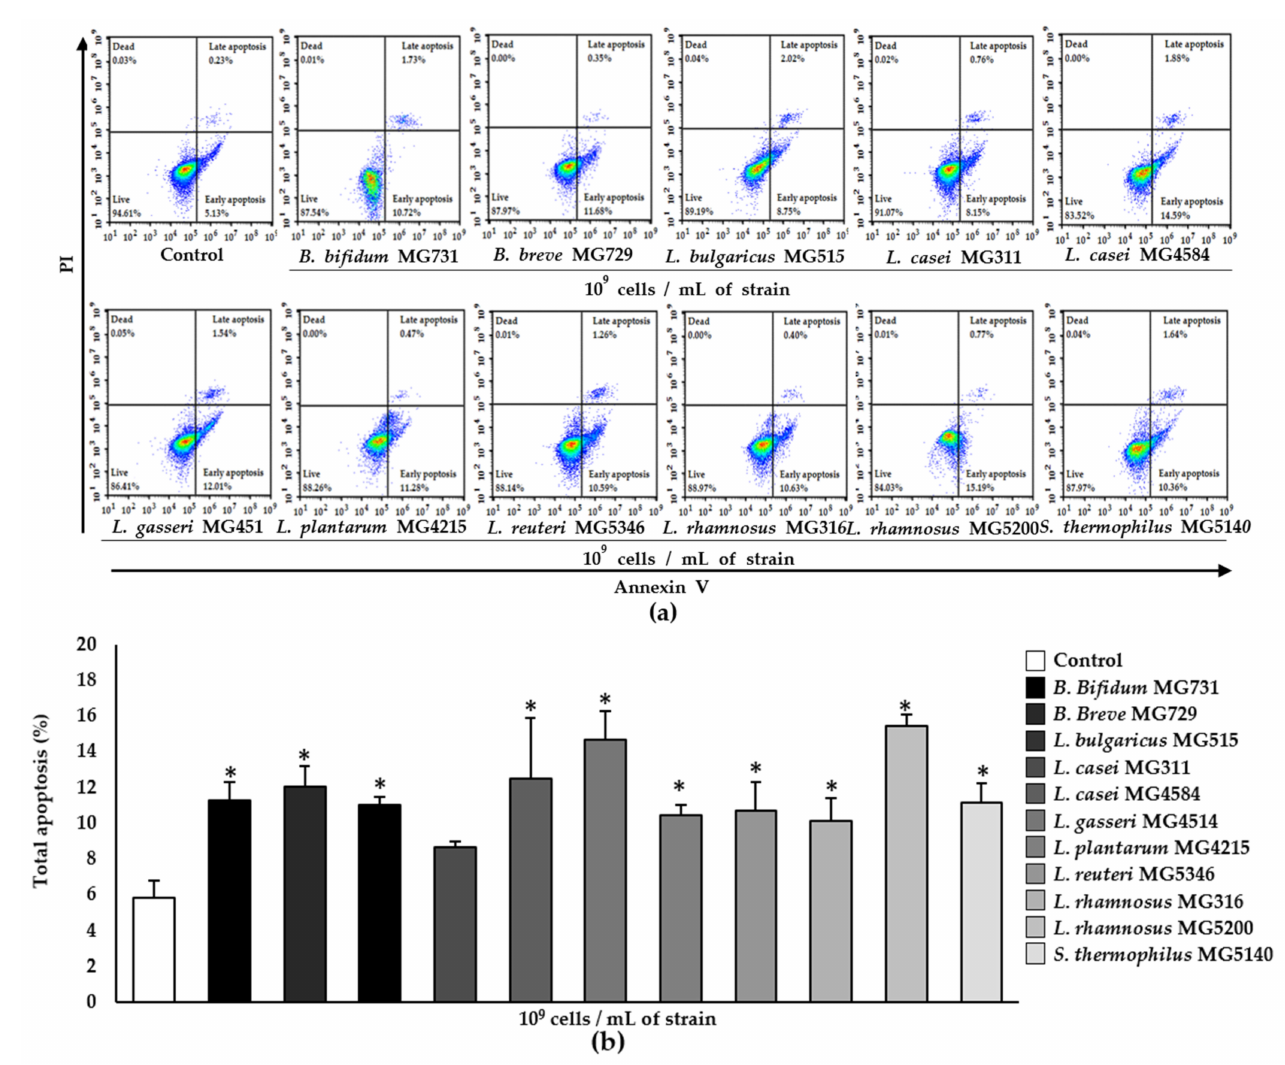
Figure 2. Apoptosis induced by heat-killed Bifidobacterium and Lactobacillus in RKO cells analyzed by flow cytometry. ( a ) Representative Annexin V and PI staining for apoptosis and ( b ) total apoptosis (%). Data represent mean ± SD ( n = 3), * p < 0.05 vs.